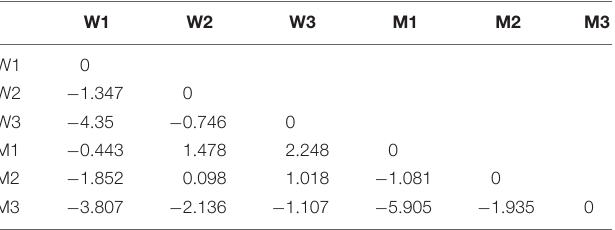
TABLE 7C | Moderation analysis: critical ratio for differences (comparison between men and women for PGE).